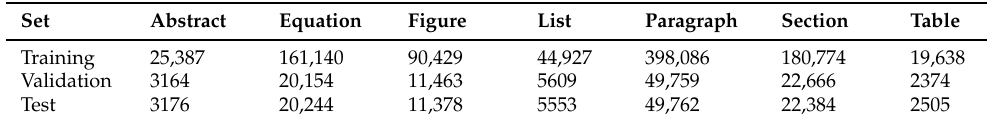
Table 5. Statistics of the most relevant classes to the task of graphical page object detection in the training, validation, and testing sets in DocBank [45]